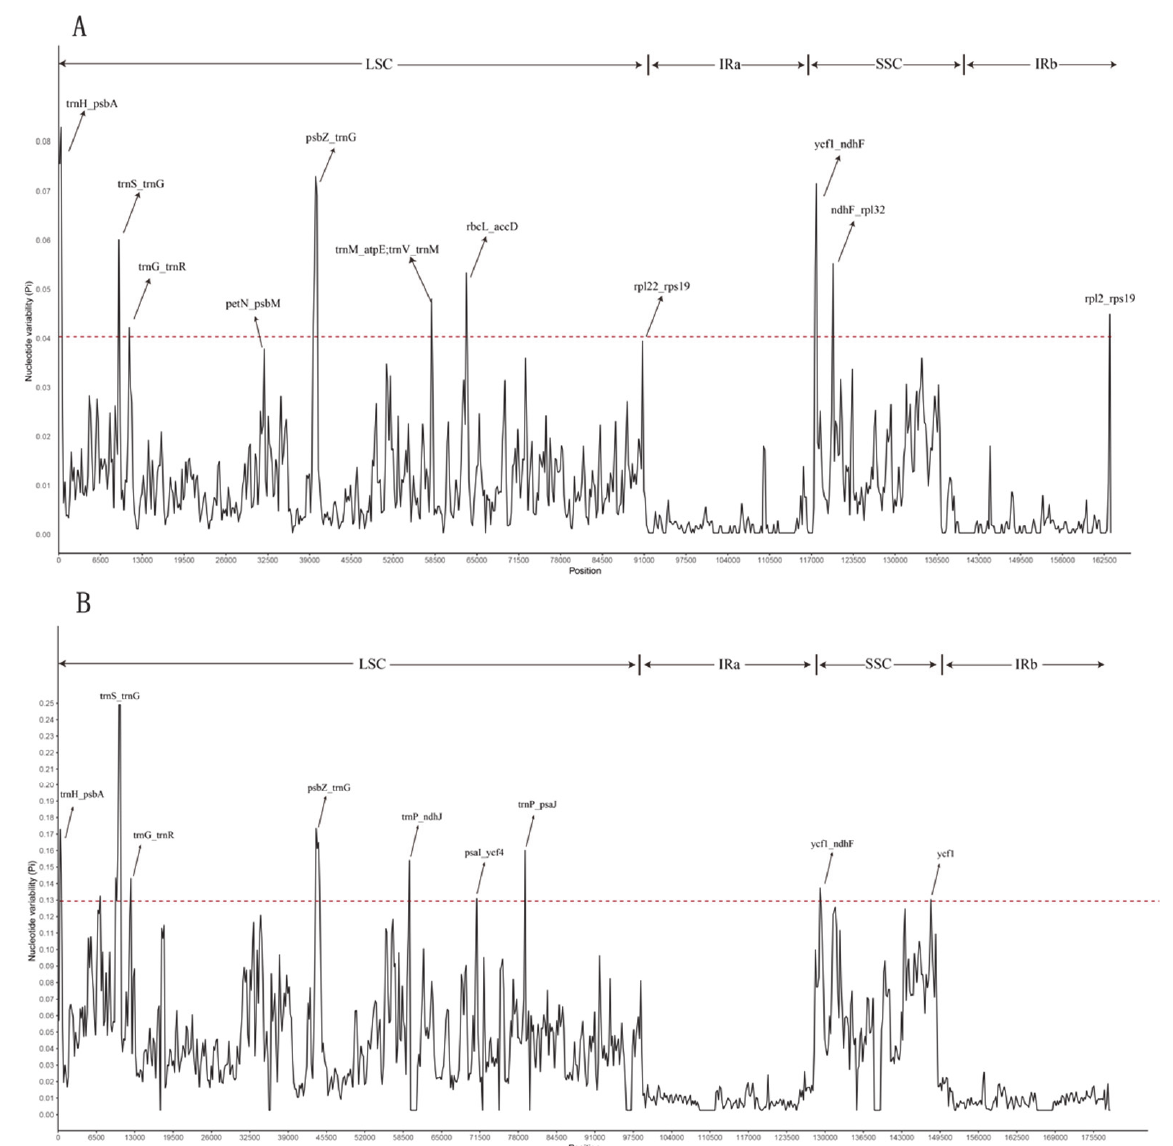
Figure 12. Sliding-window analysis of chloroplast genome sequences of ( A ) Euonymus species and Figure 12. Sliding ‐ window analysis of chloroplast genome sequences of ( A ) Euonymus species and ( B ) Celastraceae species. ( B ) Celastraceae species. Table 5. Eleven regions of highly variable sequences (Pi > 0.03) of Euonymus Table 5. Eleven regions of highly variable sequences (Pi > 0.03) of Euonymus species.